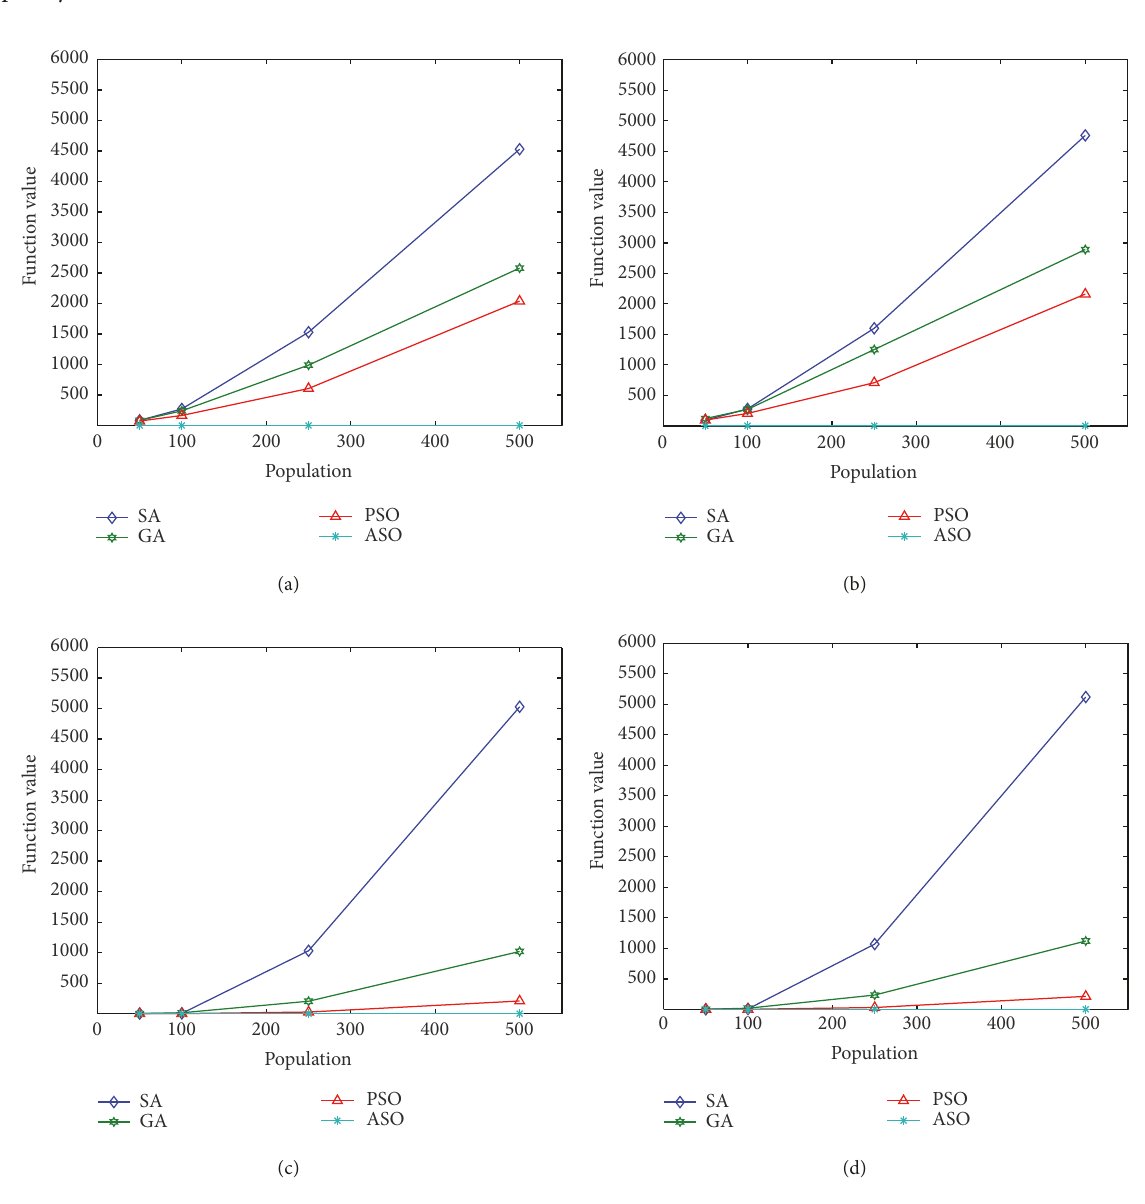
Figure 3: Fitness value variations with respect to